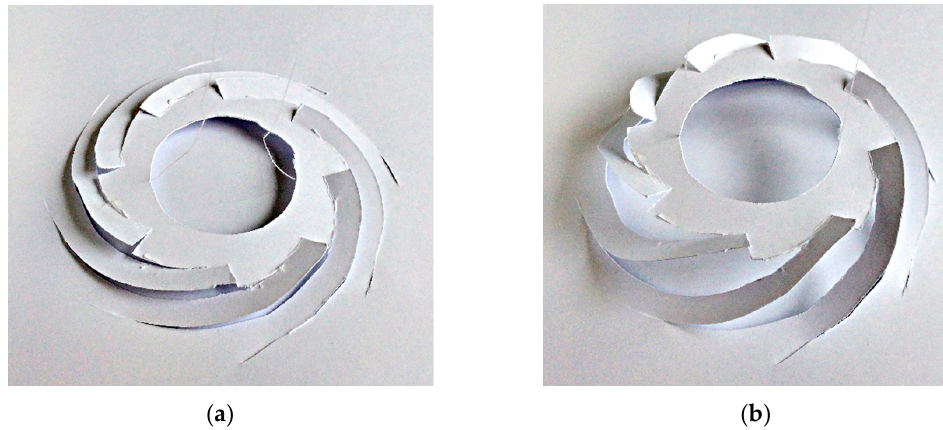
Figure 1. Paper model of the proposed kirigami scanner: ( a ) unfolded state and ( b ) folded state.